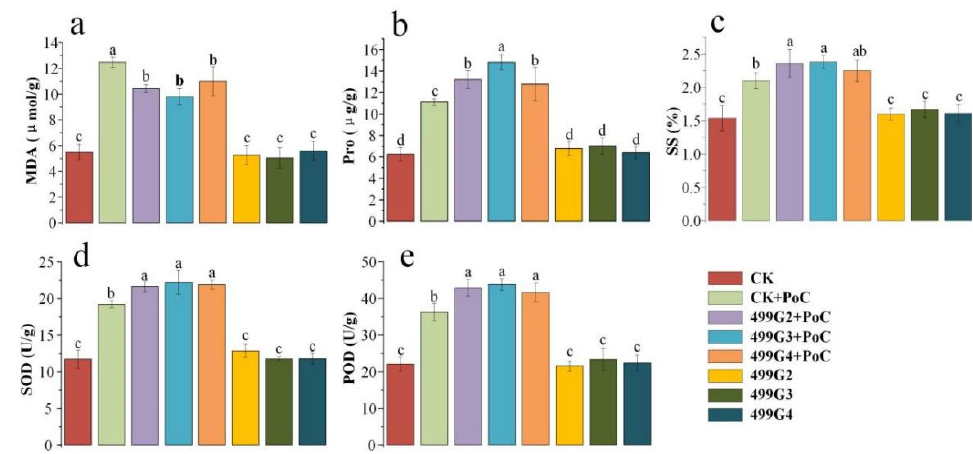
Figure 6. Effects of the inoculation of the screened bacteria and M. grisea on the content of MDA ( a ), Pro ( b ), SS ( c ), SOD ( d ) and POD ( e ) in rice leaves. CK, blank control; CK + PoC, rice blast control; 499G2 + PoC, 499G2 and rice blast together application; 499G3 + PoC, 499G3 bacteria and rice blast were applied together; 499G4 + PoC, 499G4 bacteria and rice blast were applied together; 499G2, 499G2 bacteria were applied alone; 499G3, 499G3 bacteria were applied alone; and 499G4, 499G4 bacteria were applied alone agent. Error bars represent standard errors ( n = 3). Different lowercase letters show statistically significant difference ( p value < 0.05).